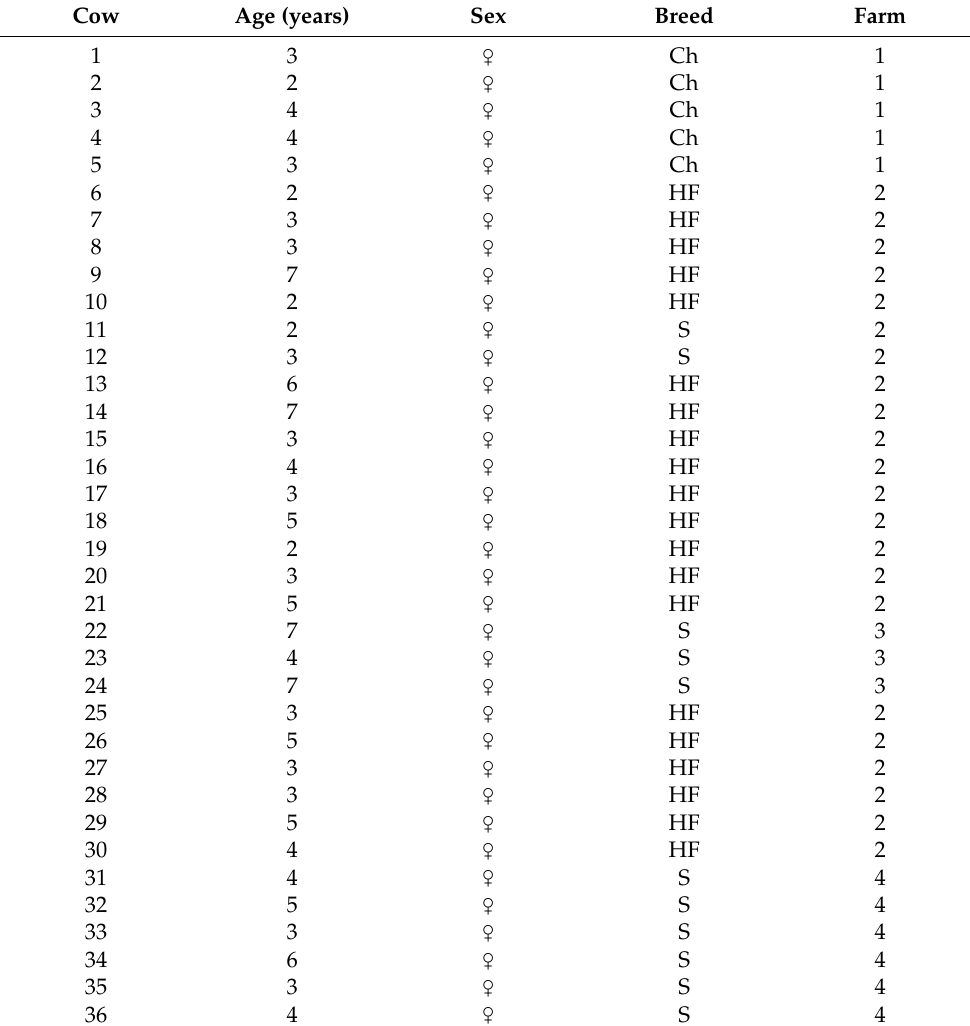
Table 3. Specification of skin samples in cattle with digital dermatitis. Cow Age (years)